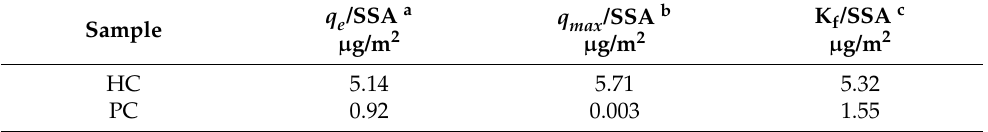
Table 6. Surface area normalized adsorption maximum values of Cd adsorption for HC and